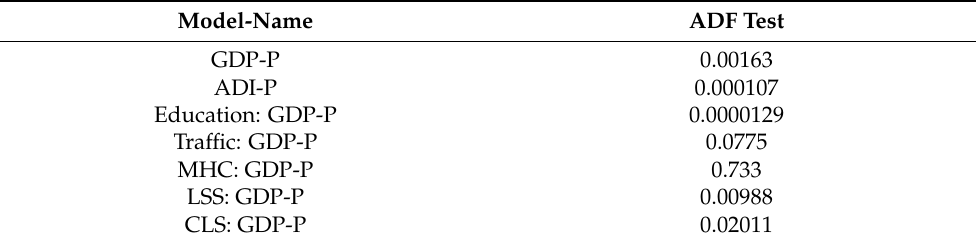
Table 11. The test results of cointegration between life satisfaction and each model. Model-Name ADF Test GDP-P 0.00163